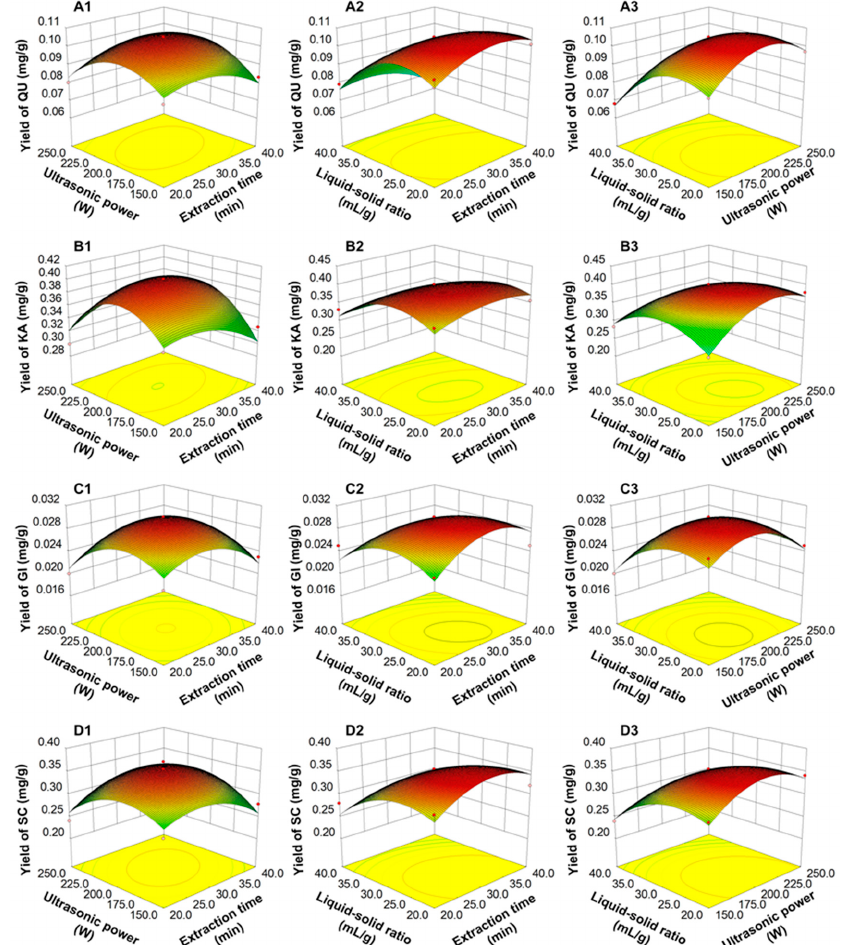
Figure 5. Response surface diagrams indicating the effects of variables (ultrasonic power, W; extraction time, min; liquid–solid ratio, mL/g) on the yields of QU, KA, GI and